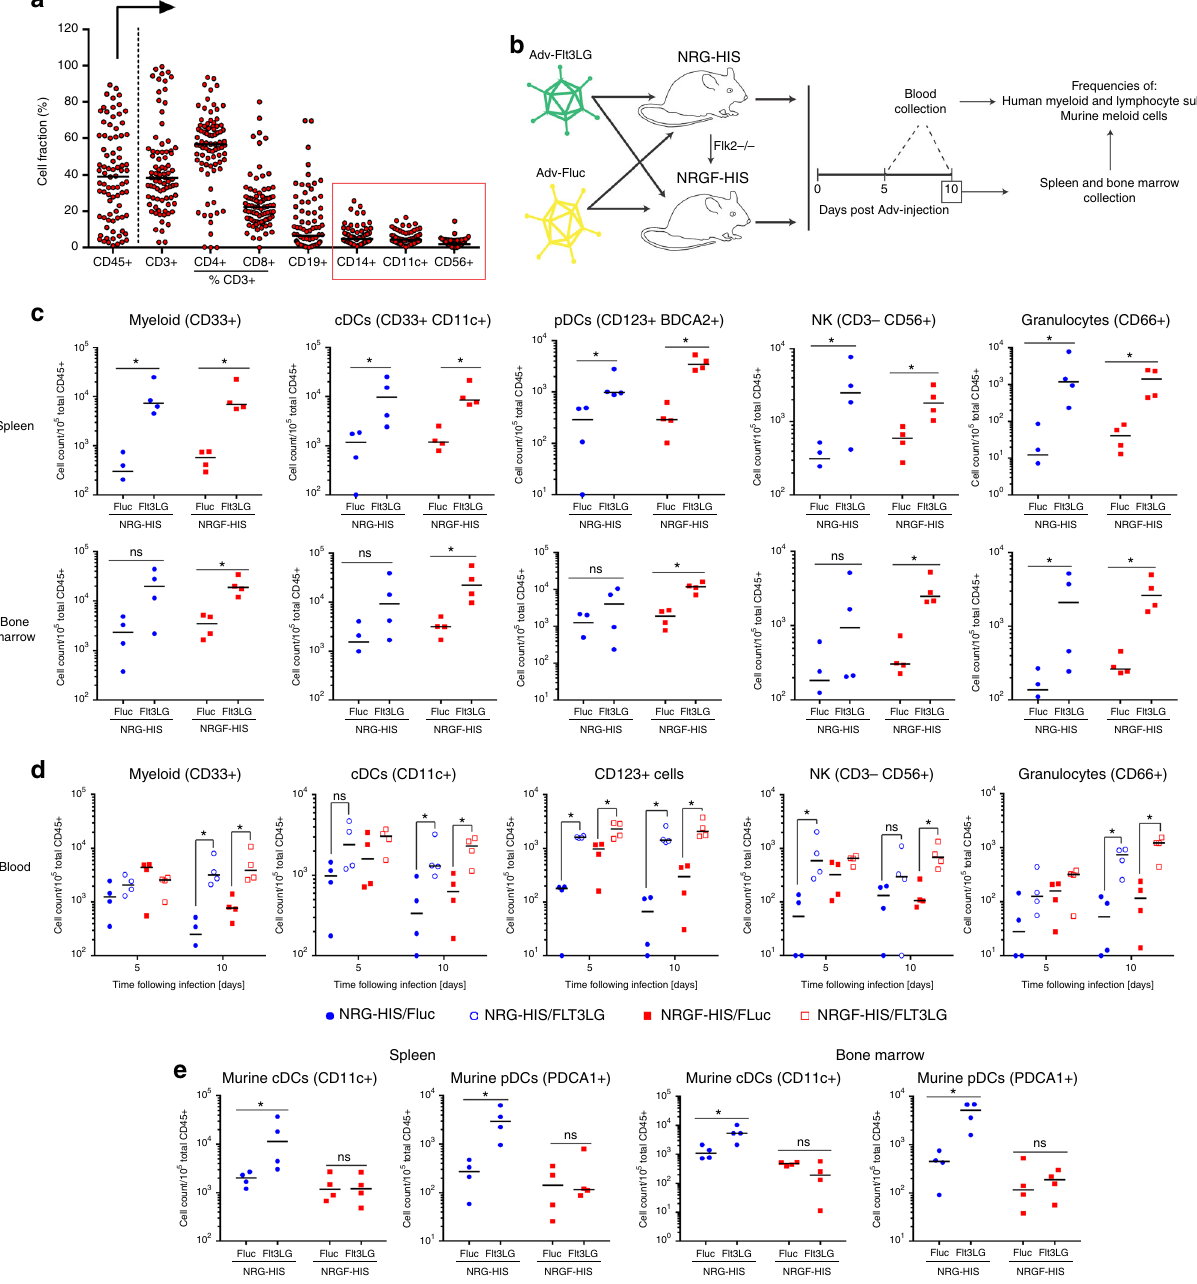
Fig. 3 Selective expansion of human myeloid cells and NK cells in humanized mice. a Immune system reconstitution in NRG-HIS mice. Frequency of each cell fraction is shown as a percentage of CD45 + cells, with the exception of CD4 + and CD8 + T cells, which are displayed as a percentage of CD3 + T cells. The frequencies of important myeloid subsets (CD14 + monocytes and CD11c + dendritic cells) and CD56 + NK cells are highlighted by a red box. Medians are shown for each cell subset frequency as horizontal black line ( n = 82). b Schematic representation of the experimental procedure employed to evaluate the ability of NRGF-HIS mice to selectively expand human myeloid cell subsets. 10 11 AdV-Fluc or 10 10 AdV-Flt3LG particles were injected into NRG-HIS or NRGF-HIS mice, and immune cell expansion was examined at day 5 and 10 post Adv-injection. c , d Expansion of human immune cell subsets in the spleen ( c ), bone marrow ( c ) or blood ( d ) of NRG-HIS and NRGF-HIS mice. NRG-HIS (blue circle) and NRGF-HIS (red square) mice were injected with AdV-Fluc (closed circle/square in panel c ) or AdV-Flt3LG (open circle/square in panel c ). e Expansion of murine cDCs and pDCs in the spleen and bone marrow of NRG-HIS and NRGF-HIS mice following injection with AdV-Flt3LG or AdV-Fluc. For panels ( c – e ), medians are shown as horizontal black lines for each experimental condition ( n = 4 per group). * p ≤ 0.05, ns non-signi fi cant (Wilcoxon – Mann – Whitney test). cDCs conventional dendritic cells, pDCs plasmacytoid dendritic cells, NK natural killer